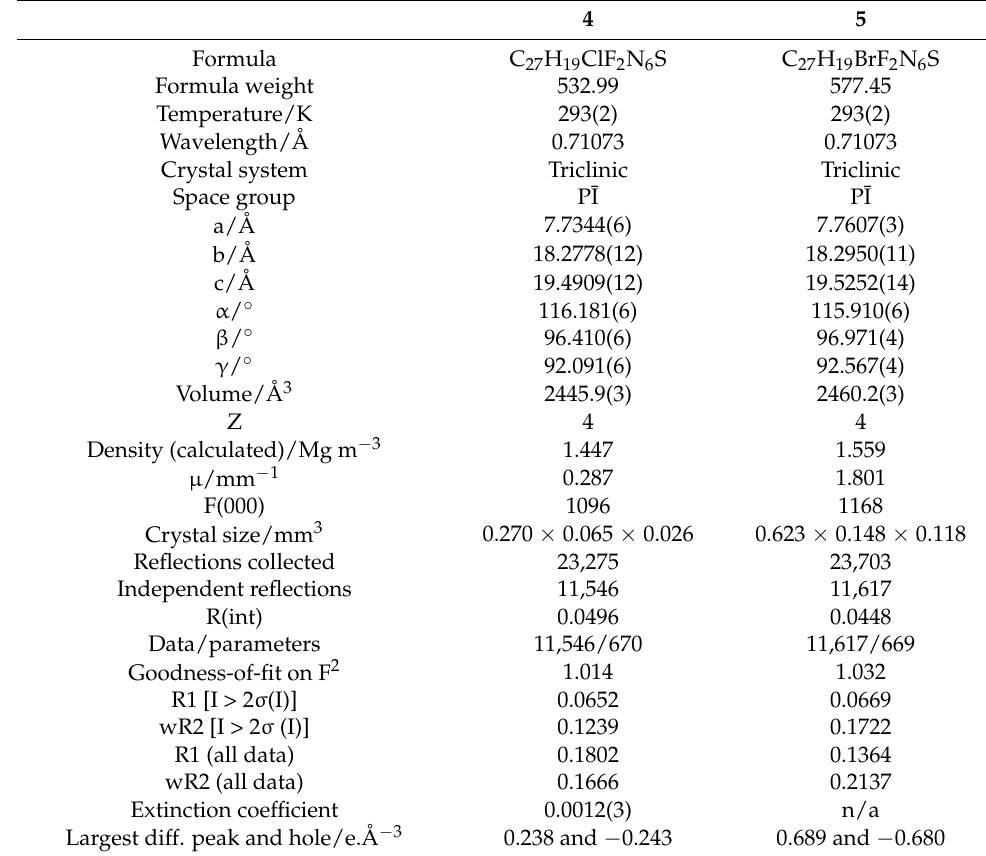
Table 1. Crystal and structure refinement data for 4 and 5 .